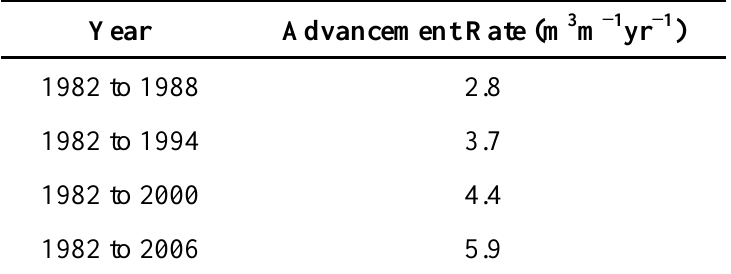
Table 1. The advancement rate recorded during the 24-year period from 1982 to 2006 for the Kelso